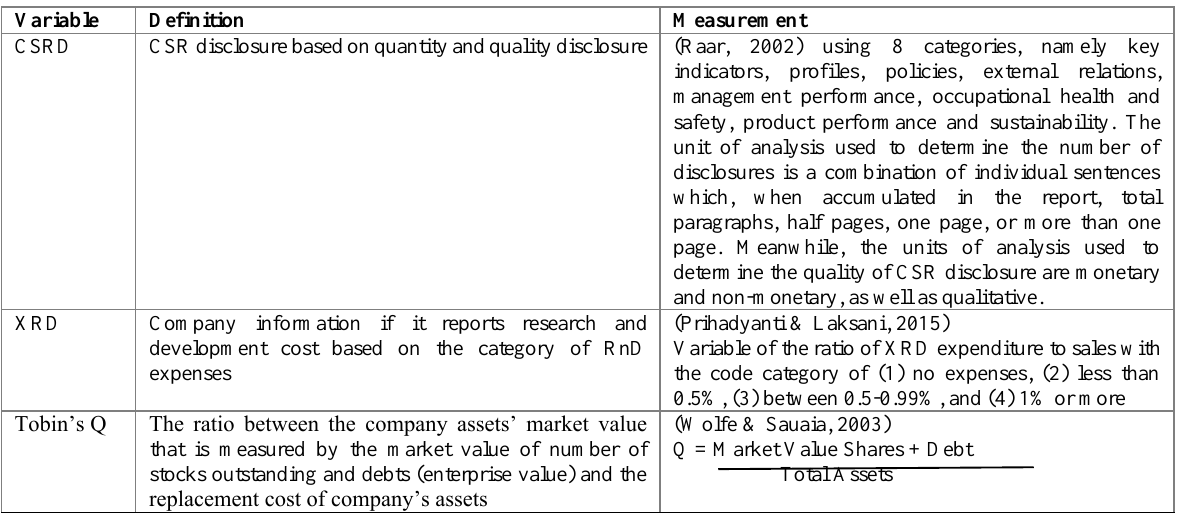
Table 1: Operational Variable